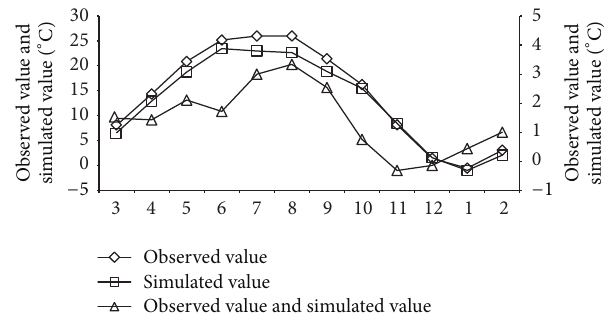
Figure 4: Comparisons of simulated and observed values of the monthly average temperature at 2 meters above the